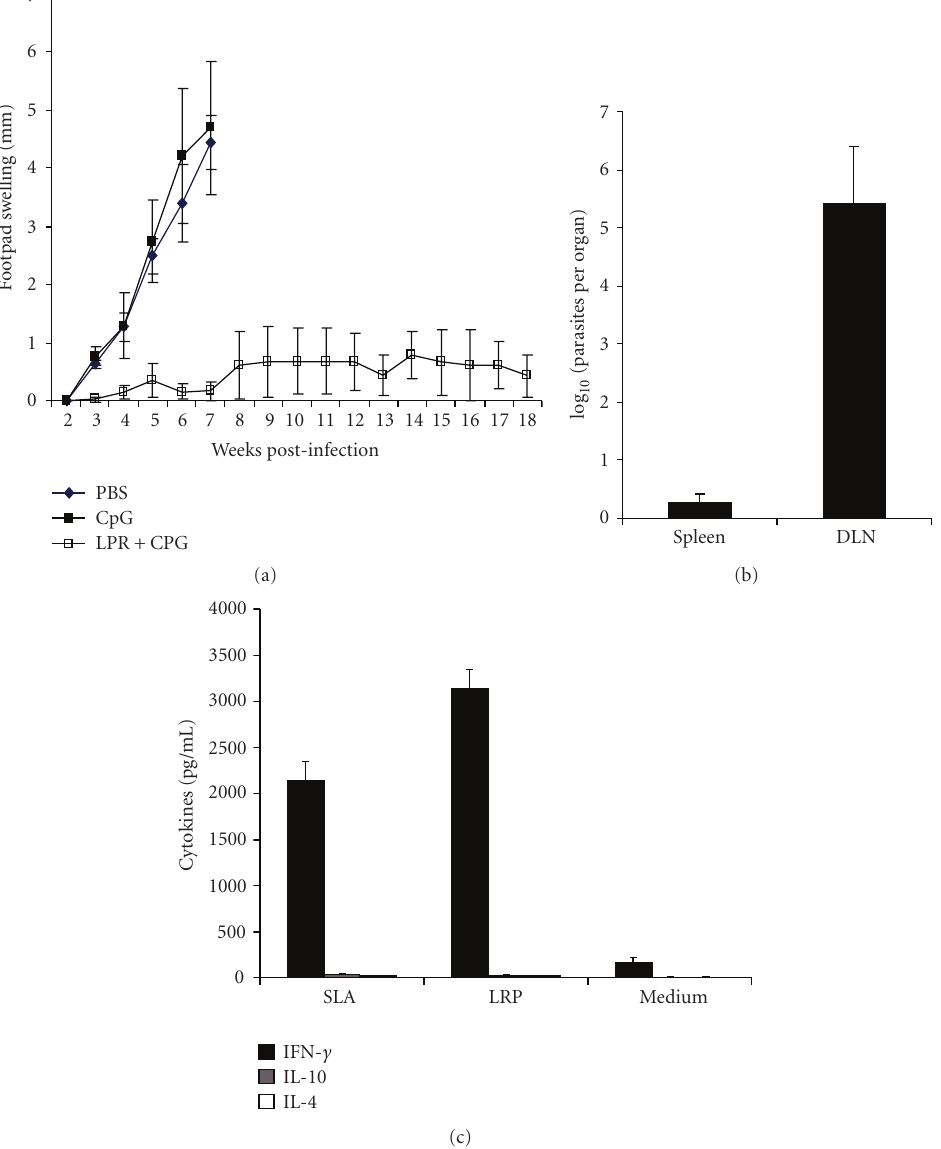
Figure 1: Course of L. major infection in BALB/c vaccinated mice. Mice (six per group) were s.c. immunized in the right footpad with three doses of the LRP adjuvated with CpG ODN (LRP + CpG), with the CpG ODN adjuvant (CpG) or with PBS. One month after the last immunization, the animals were infected in the left hind footpad with 5 × 10 4 L. major stationary phase promastigotes. (a) Footpad swelling is given as the di ff erence of thickness between the infected and the uninfected contralateral footpad. (b) The number of viable parasites in the spleen and the popliteal DLN of the LRP + CpG ODN vaccinated were individually determined by limiting dilution at week eighteen post challenge. Results are expressed as the mean ± SD of six spleens and popliteal DLN. (c) At week eighteen after footpad infection the level of IFN- γ , IL-10 and IL-4 was measure by ELISA in the supernatants of popliteal lymph node cells cultures from LRP + CpG ODN vaccinated mice. Cells were in vitro stimulated for 48 hours with 12 μ g/ml of SLA or LRP and medium alone. Results are expressed as the mean ±